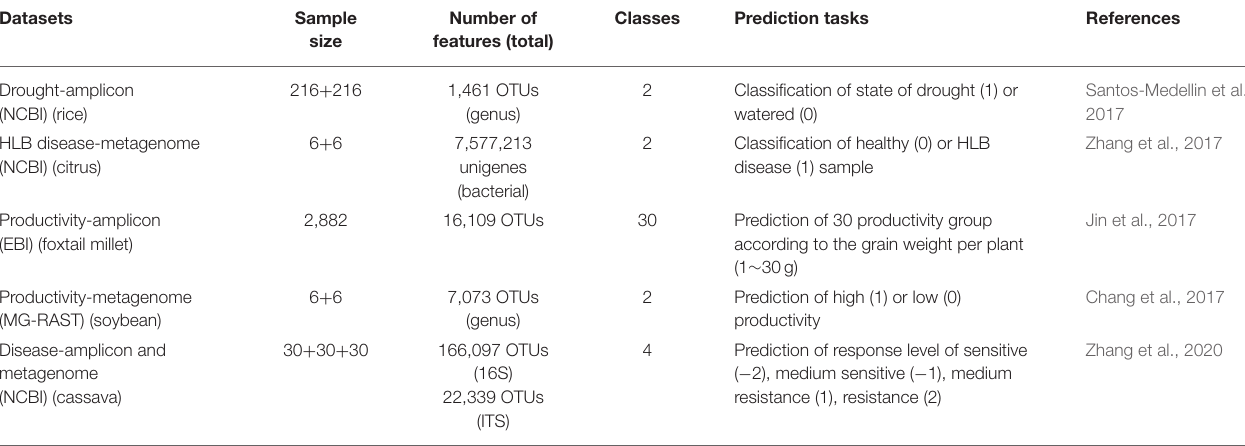
TABLE 2 | Datasets of the plant-associated